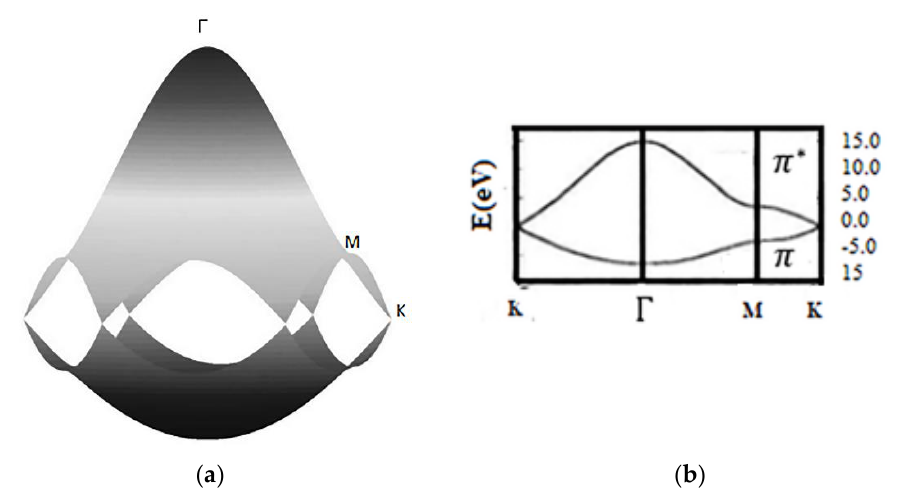
Figure A3. Energy dispersion. ( a ) A 3D band structure; ( b ) 2D band structure in the high symmetry point route. By Slater-Koster [16] approximation s = 0, the dispersion equation becomes: